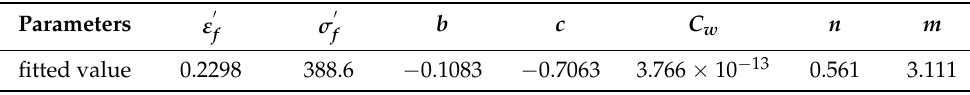
Table 4. The value of the fitted parameters. [54].